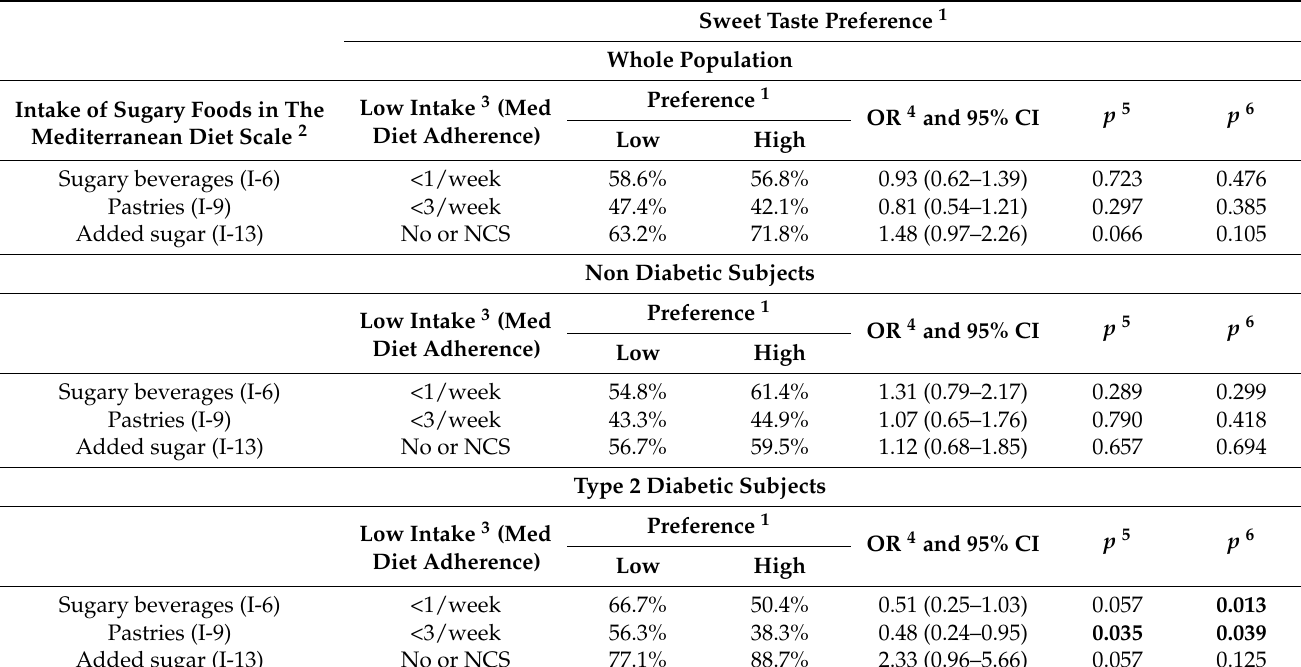
Table 6. Association between sweet taste preference (low and high) and intake of sugary foods included in the Mediterranean diet scale. Analysis in the whole population and by type 2 diabetes